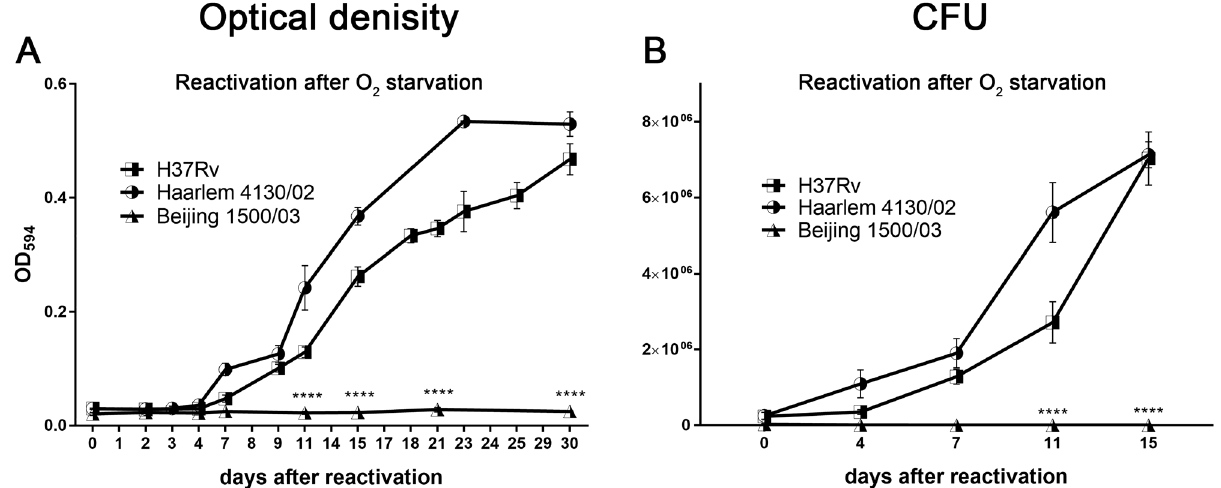
Figure 3. After hypoxia-induced dormancy, H37Rv (L4) and Haarlem (L4), but not Beijing (L2) reactivated by oxygen exposure. 35 days after oxygen starvation, M. tuberculosis strains were inoculated in fresh medium under atmospheric oxygen conditions. At indicated time points, mycobacterial growth was measured by optical density ( A ) or bacteria were plated for CFU analysis ( B ). n = 3 independent experiments with triplicates in each, ****p < 0.0001, two-way ANOVA.